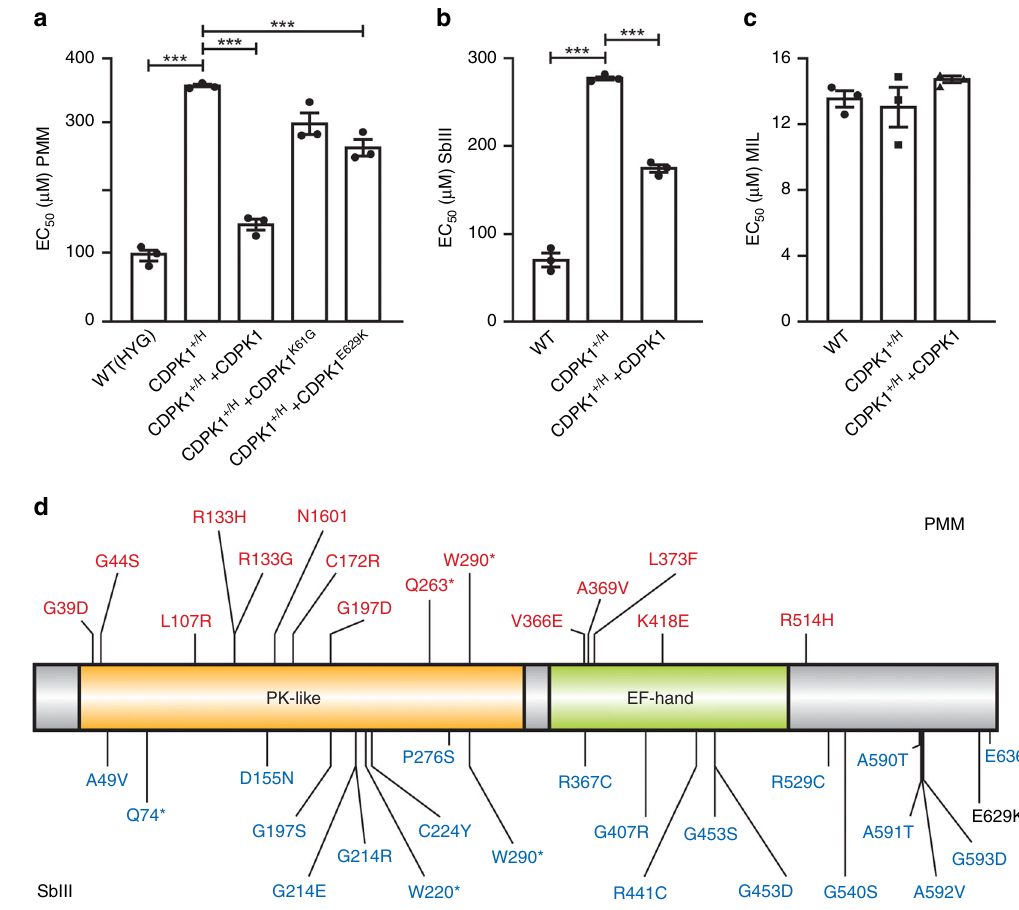
Fig. 4 CDPK1 is linked to paromomycin and antimonial resistance. a Dose responsiveness to PMM of the single knockout line CDPK1 + /H complemented with an episomal rescue coding for the wild-type, K61G or E629K versions of CDPK1. Superscript H and + refer to the HYG -inactivated and wild-type alleles, respectively. Data are mean ± SEM for n = 3 biological replicates. Statistical analyses were performed using unpaired two-tailed t -tests.*** P < 0.001; ** P < 0.01. Dose responsiveness against SbIII ( b ) and miltefosine ( c ) for the single knockout line CDPK + /H complemented or not with an episomal rescue coding for the wild-type protein. Data are mean ± SEM for n = 3 biological replicates. Statistical analyses were performed using unpaired two-tailed t -tests. *** P < 0.001. d Mutations in CDPK1 detected in PMM (red) and SbIII (blue) resistant mutants. The mutation in black (E629K) was detected in one mutant selected by step wise exposure to SbIII in an independent study 32 . An asterisk represents a stop codon. Source data are provided as a Source Data fi